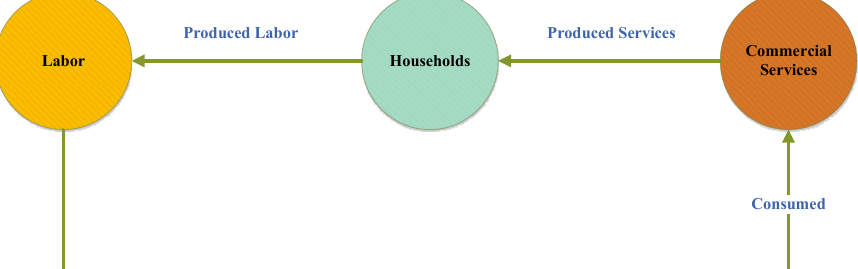
Figure 7. Location choice behavior of